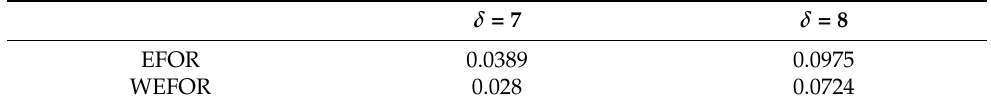
Table 5. Comparison of the NMSE.